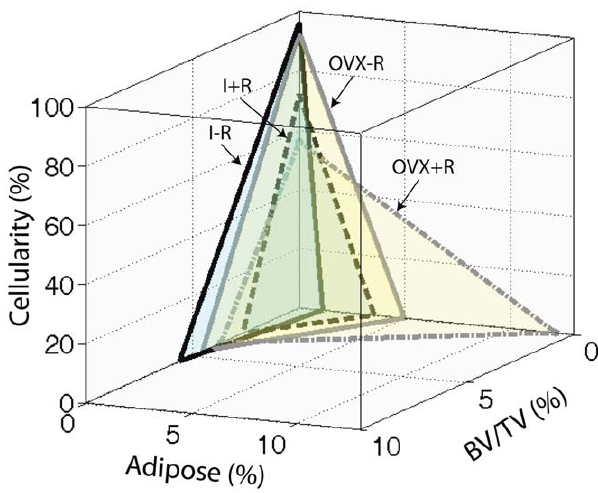
Figure 5. 3-D illustration of interrelationships among the three tissue components of bone and marrow: hemopoietic compo- nent measured by cellularity, stromal damage component measured by marrow fat or adipose content, and osseous component measured by the cancellous bone BV/TV%. Cumulative increases in marrow fat after irradiation, in the absence of ovarian function (10 fold) was not reflected by equivalent losses of either cancellous bone or hematopoietic cellularity. The proportionality of changes in these tissue components were maintained among irradiated intact